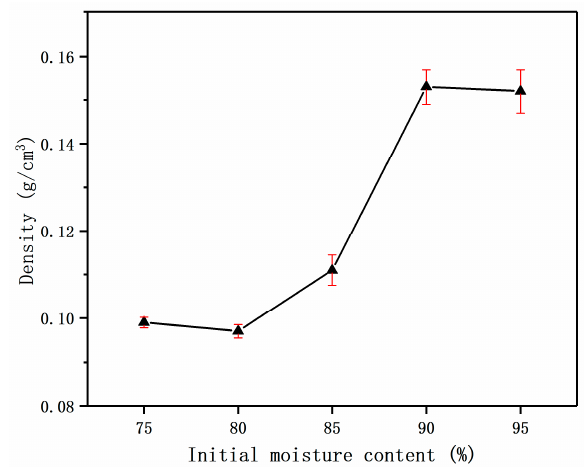
Figure 3. Effect of different initial moisture content on density.